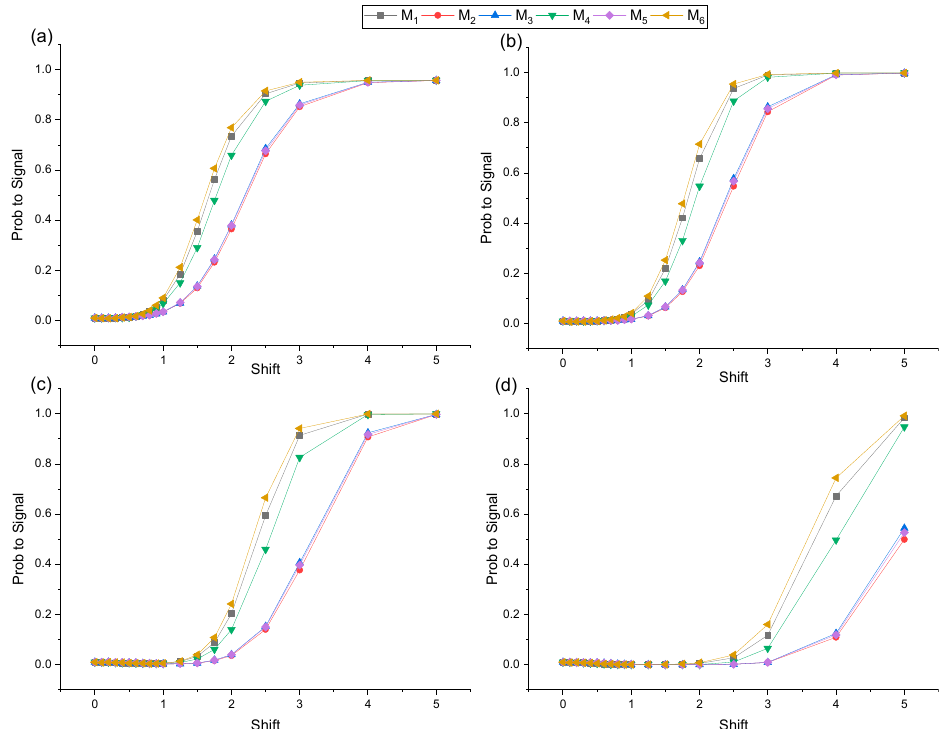
Figure 2. Probability to signal plot for different auxiliary information based median charts using n = 10, m = 30, ρ = 0.30 and α = 0.01 at ( a ) m 1 = 3, ( b ) m 1 = 6, ( c ) m 1 = 9, ( d ) m 1 = 12. Mathematics 2020 , 8 , x FOR PEER REVIEW